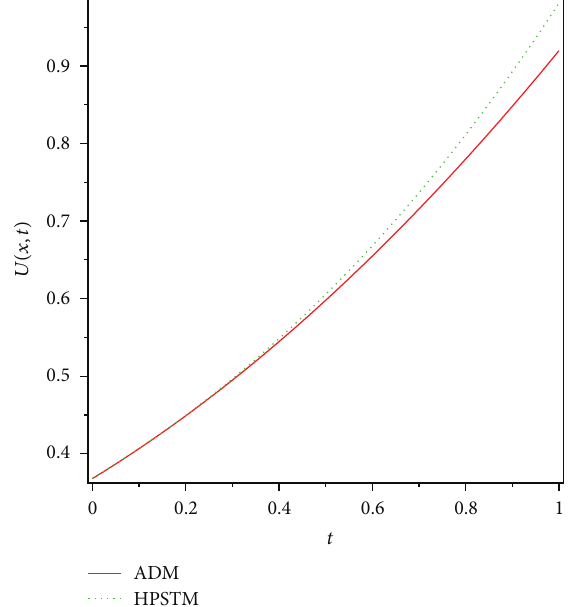
Figure 3: Comparison of the HPSTM and the ADM when 𝑥 = 1 and 𝛼 = 1